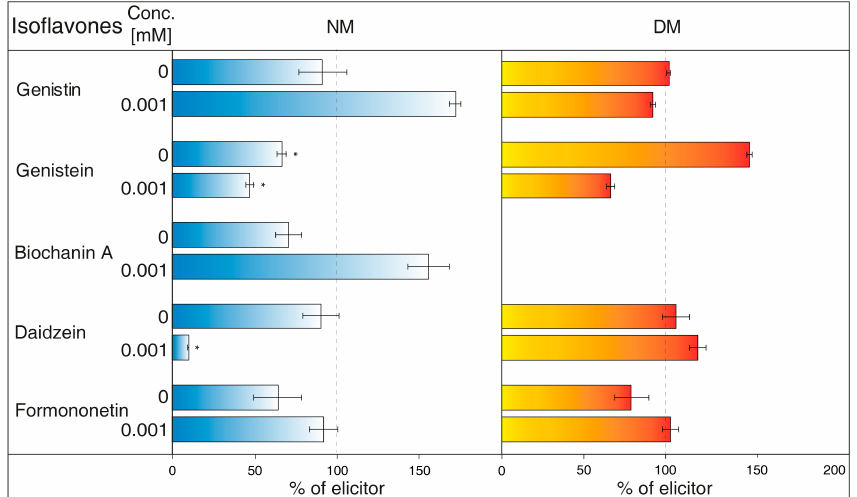
Figure 3. Effects of gramicidin on isoflavone content in nutrient medium (NM) and dry matter (DM) of Genista tinctoria cell culture. Zero concentration of inhibitor represents water control. All bar values were recalculated to a relative 100% isoflavone content in samples with NH 4 VO 3 (1 μ M) after 24 h. Data are mean of three repeats ± SE; (*) represent significant difference ( p < 0.05) between elicited and inhibited or water control samples within Tukey’s test.